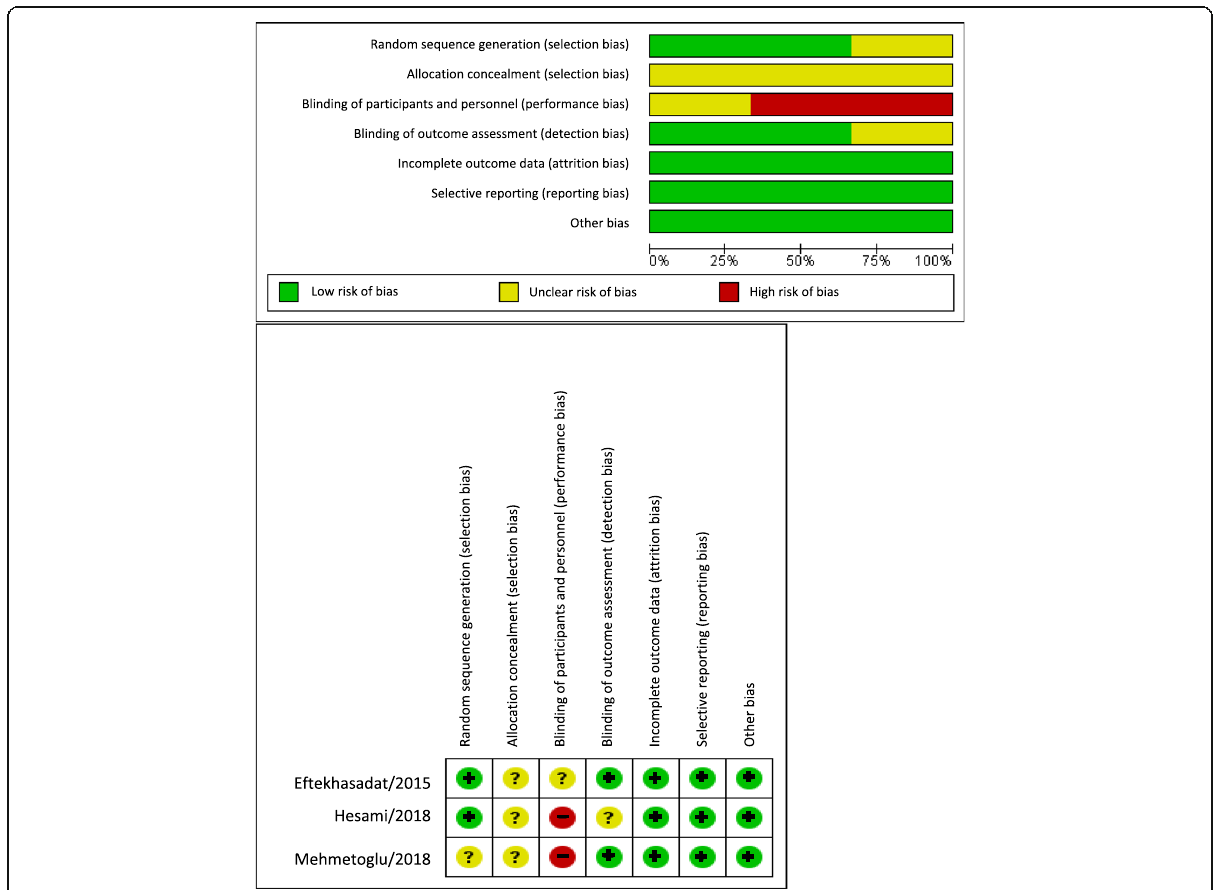
Fig. 2 Summary of quality assessment among included